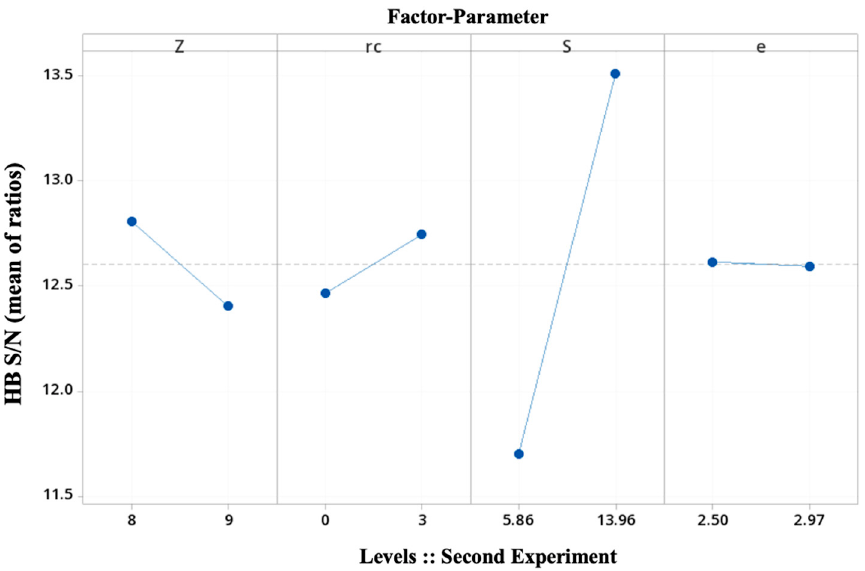
Figure 10. Main effects plot for the second Taguchi experiment (see Table 5).